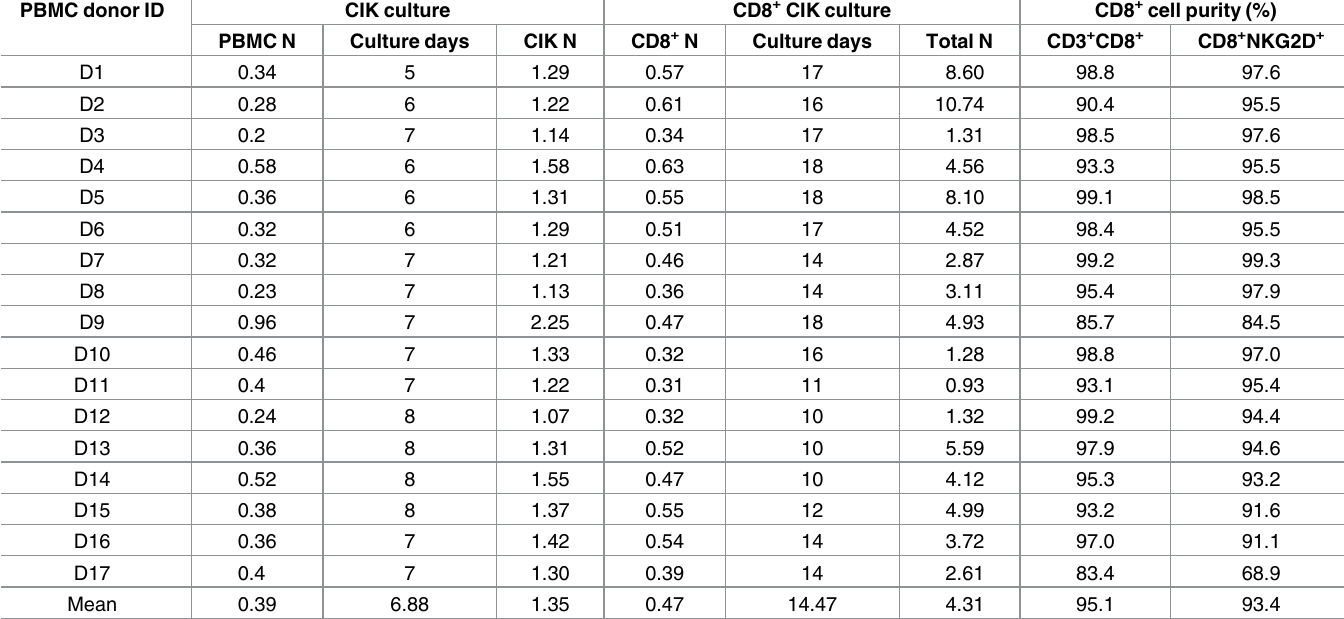
Table 2. The cell purity and proliferation ability of CIK and CD8+ CIK cells. PBMC donor